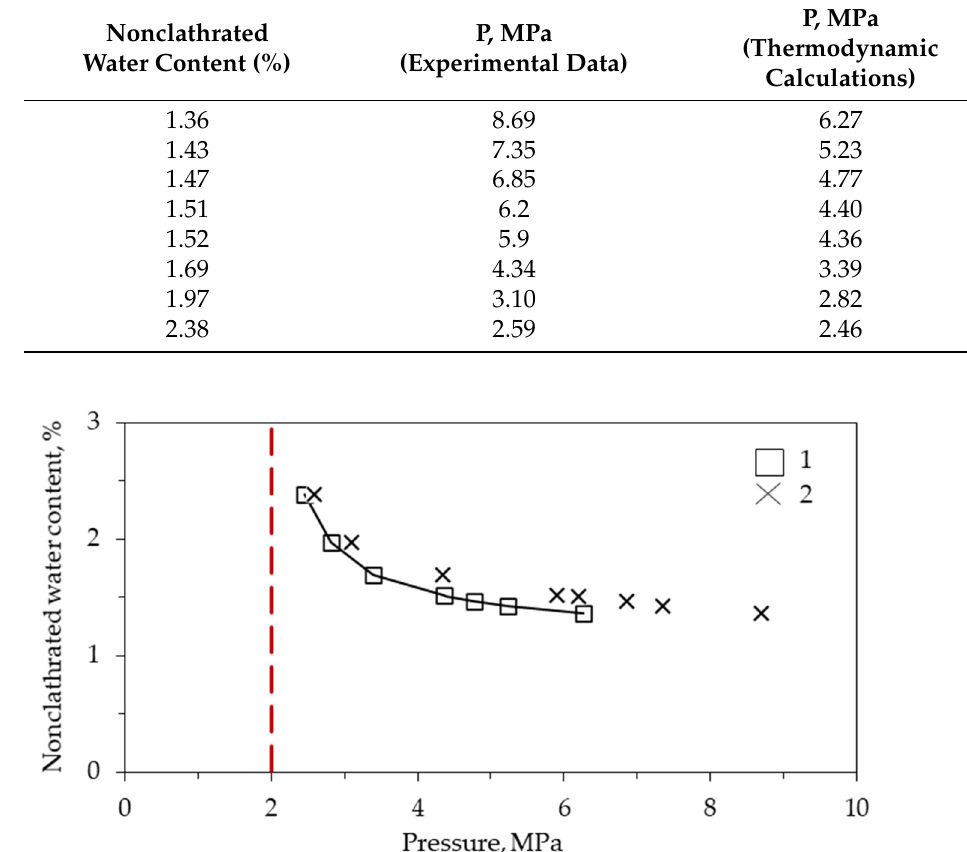
Table 6. Experimental data for determination of nonclathrated water at P > P ice eq = 2.00 MPa, obtained by contact method for kaolinite clay and its calculations by using Equation (21) and n = 6.033 at 265.65 K temperature.